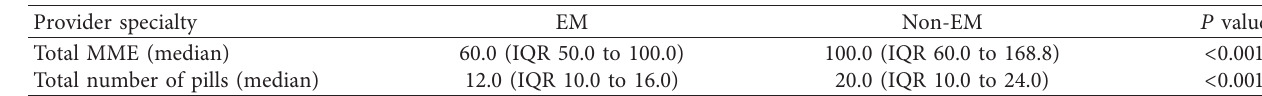
Figure 3: Subgroup analysis-total number of pills. This subgroup analysis depicts how each provider type (attending physician, nurse practitioner, and resident physician) prescribes. Given some formulations were prescribed as liquids, these corresponding number of pills are derived from the concentration. Table 3: Difference is prescription habits by specialty.